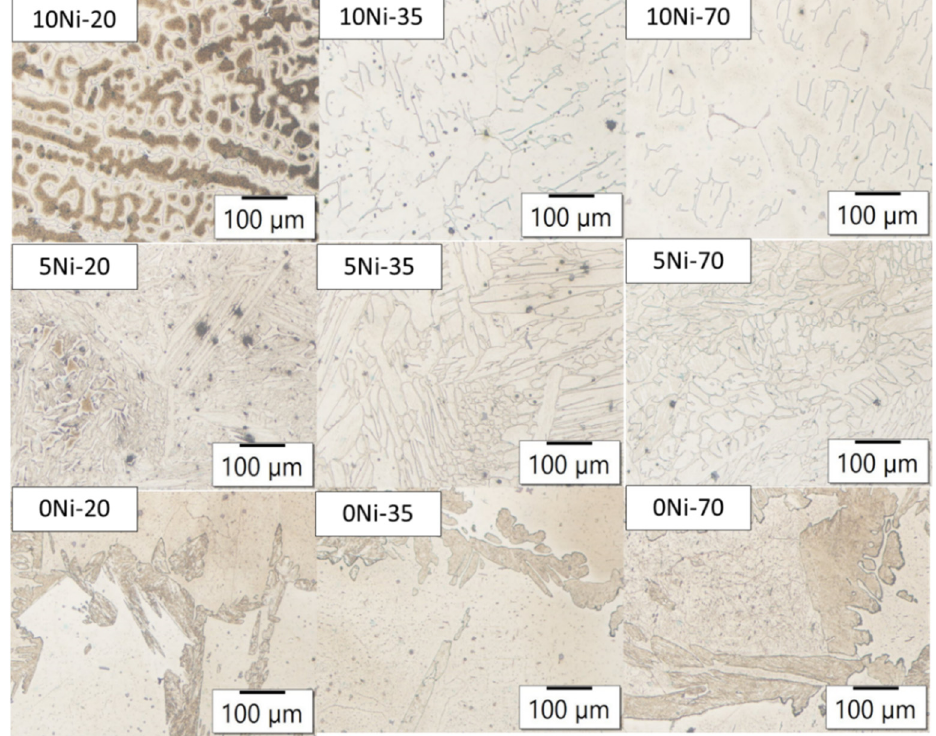
Figure 7. Optical microscopy of the as-cast microstructures of 10Ni, 5Ni, and 0Ni steels at different section diameters, etched with Vilella.